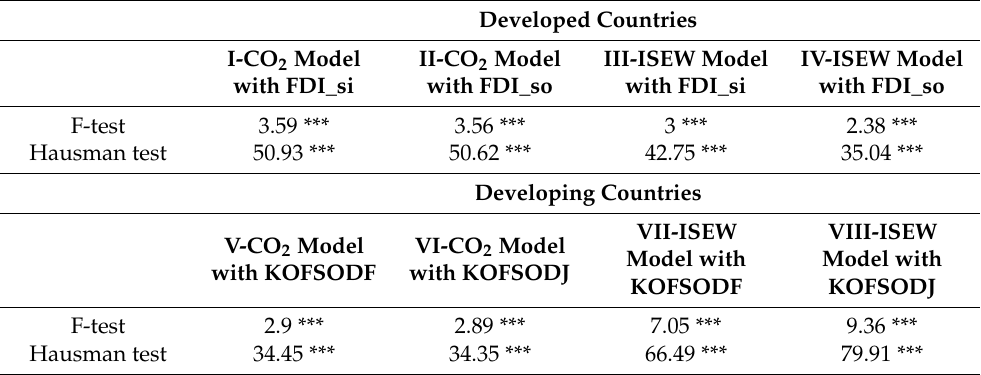
Table 9. Hausman test and